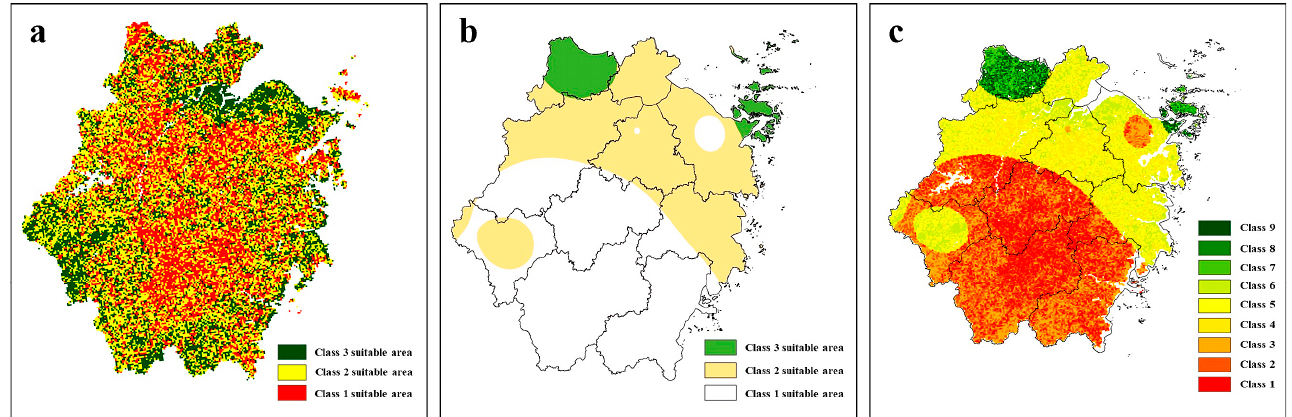
Figure 2. Results of the suitability analysis of chemical fertilizer reduction in tea plantations in Zhejiang Province. Note: ( a ) shows the results of tea planting suitability. Class 1, Class 2, and Class 3 represent the most suitable planting area, subsuitable tea planting area, and generally suitable tea planting area, respectively. ( b ) shows the results of chemical fertilizer reduction suitability. Class 1, Class 2, and Class 3 represent the most suitable reduction areas, subsuitable reduction areas, and generally suitable reduction areas, respectively. ( c ) shows the final results of chemical fertilizer reduction potential in tea plantations of Zhejiang Province. In the suitable planting areas of tea trees of classes 1, 2, and 3, the three grades of chemical fertilizer reduction zones of classes 1, 2, and 3 can be further divided. Finally, 9 corresponding fertilizer reduction areas were formed in the tea planting suitable